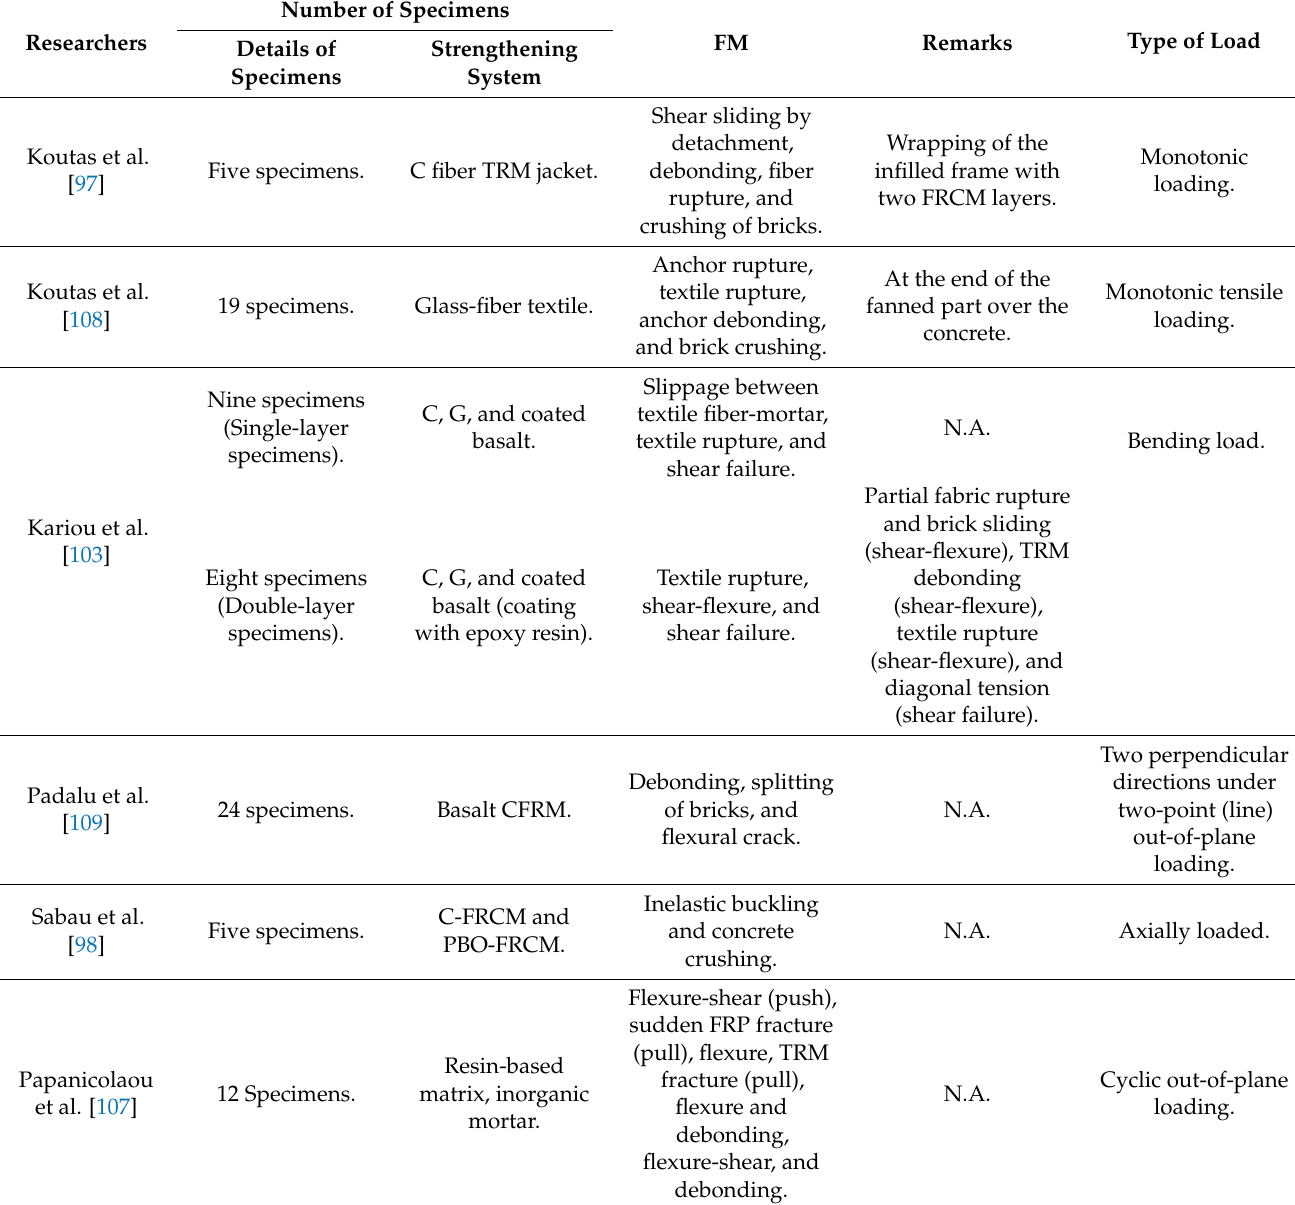
Table 17. An overview of experimental tests of strengthened walls with inorganic